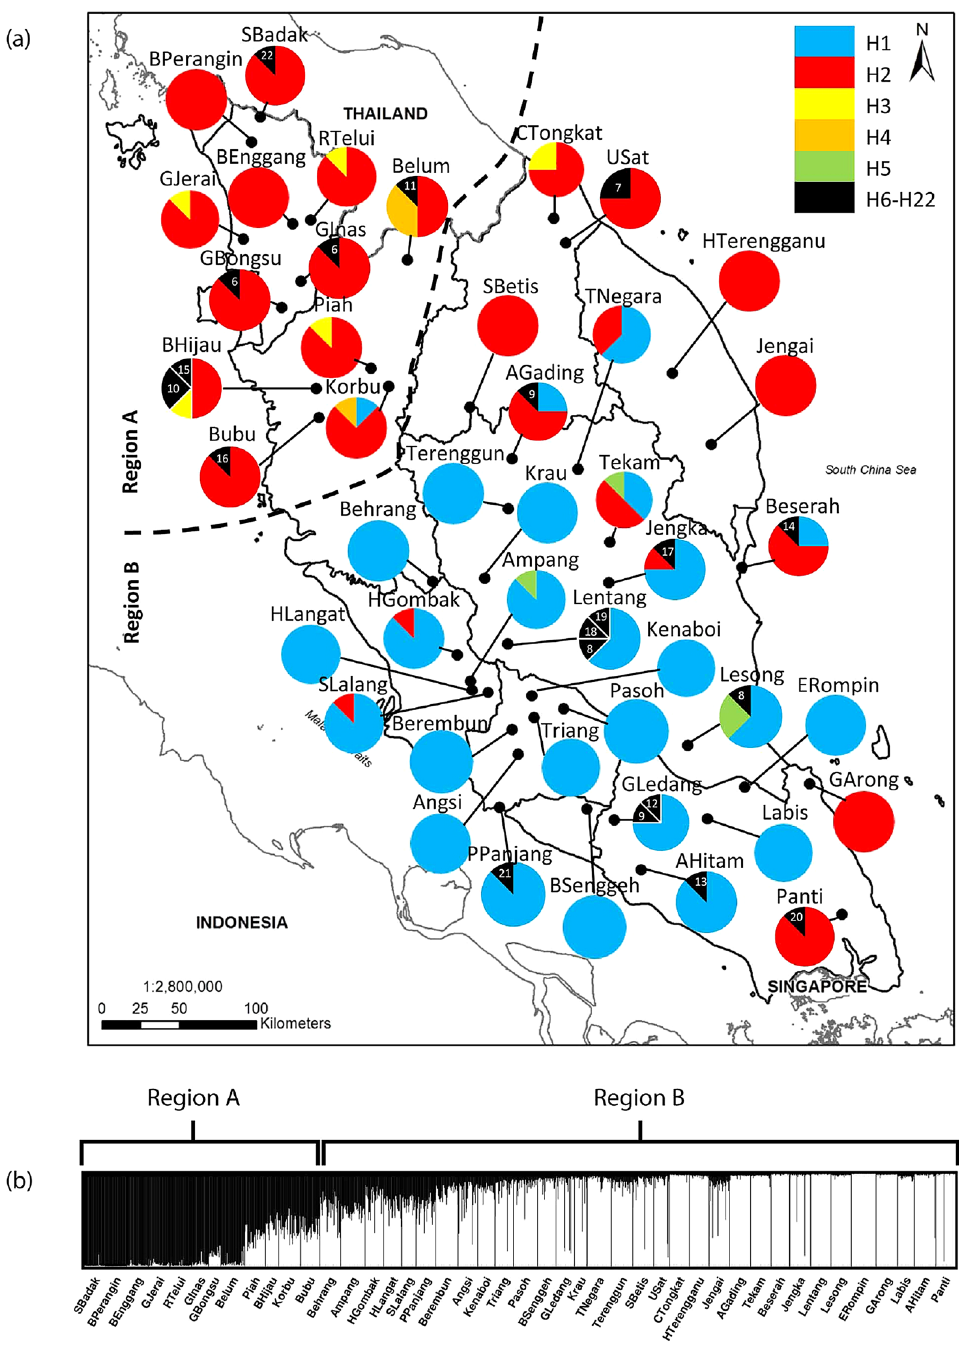
Figure 1. ( a ) Chloroplast haplotype distribution in the Shorea leprosula populations. The pie chart colours indicate haplotype distributions; and sector areas are proportional to sample size (Map was generated by ArcGIS-ArcMap version 10.8). ( b ) STRU CTU RE analysis identified two clusters ( K = 2) corresponding to Region A and